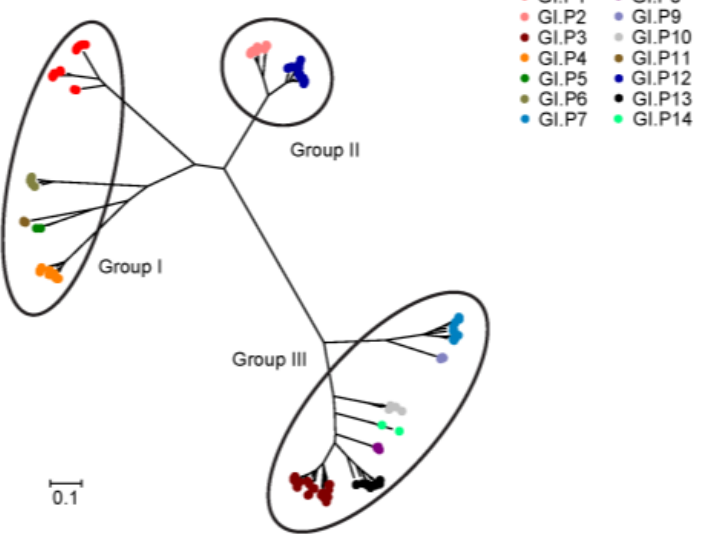
Figure 1. Molecular phylogenetic analysis of norovirus GI RdRp gene. This phylogenetic tree was constructed by the maximum likelihood method based on the general time reversible model.